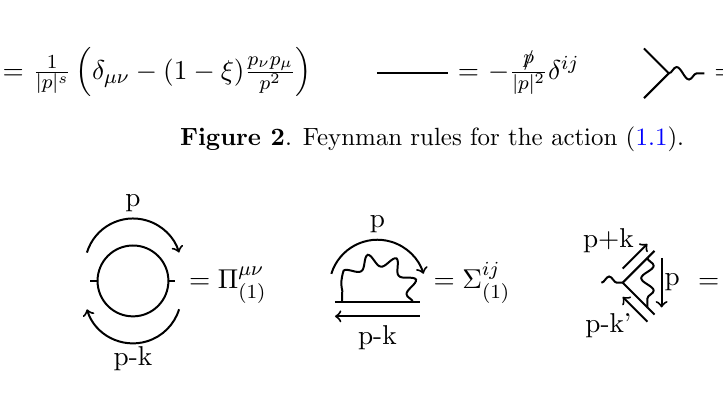
Figure 3 . One-loop diagrams associated with